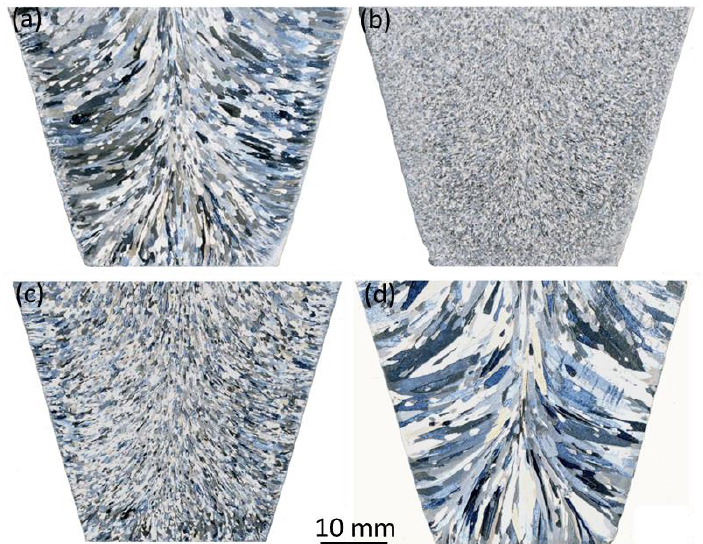
Figure 8. Grain structures of TP-1 cast CP-Al ingots reflecting the formation and dissolution of Al 3 Ti 2DC on TiB 2 surface [11]. ( a , b ) With the addition of self-made Al-1Ti-0.2B master alloy (the excess Ti and TiB 2 number density are equivalent to those of the addition of 0.2% Al-5Ti-1B grain refiner) from synthetic TiB 2 particles in Al-Ti melt by intensive melt shearing at 850 °C for ( a ) 2 min and ( b ) 10 min, showing grain refinement in ( b ) (indicating the formation of Al 3 Ti 2DC on the synthetic TiB 2 after melt shearing for 10 min); and ( c , d ) with addition of commercial Al-5Ti-1B grain refiner and then the melt was ( c ) held at 720 °C for 78 h or ( d ) treated by melt shearing for 45 min at 720 °C, showing no grain refinement (indicating dissolution of Al 3 Ti 2DC from TiB 2 surface).